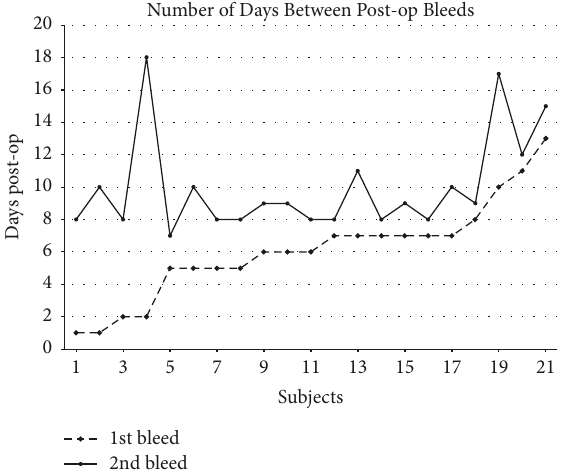
Figure 2: Number of days between posttonsillectomy bleeds. patients were taken to the OR, while only 42.86% of Group B patients were taken to the OR during their first admission, which was a significant difference (𝑃 < 0.005) . Patients not taken to the OR for their first bleed had an odds ratio of 5.78 (95% CI 2.81–11.90) of having a second bleed. For Group B, 90.48% were taken to the OR for their second bleed. Thirty- five patients (38.46%) in Group A and 8 patients (38.1%) in Group B presented with active bleeding to the ER, and the remaining had a history of bleeding or a tonsillar fossa